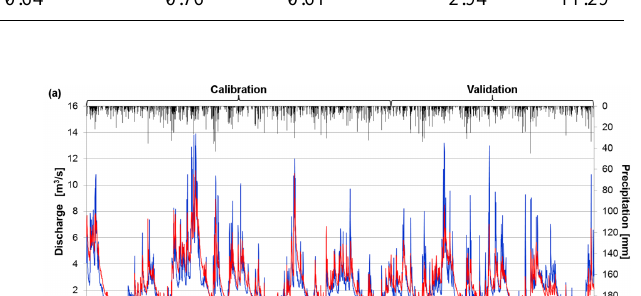
Table 3. Model performance (RSR, R 2 , NSE and PBIAS) for the different setups. Setup RSR R 2 NSE PBIAS [%] Calibration